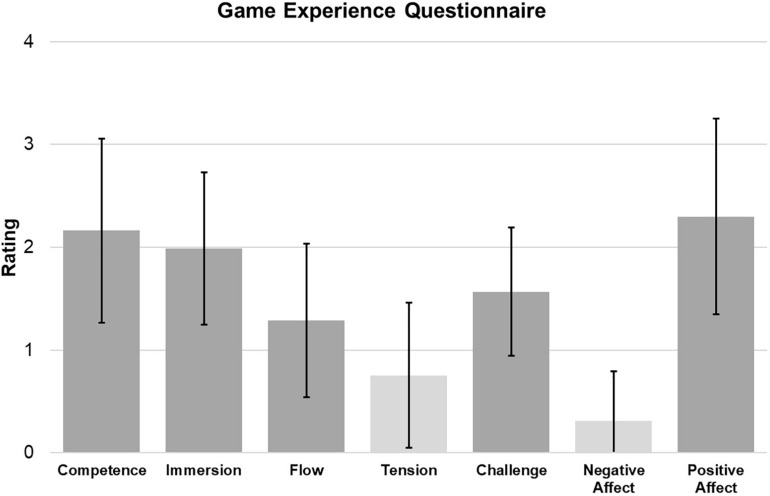
Primary outcome result of game experience. Data shown in the figure are means with standard deviations in each emotional category of the GEQ (n = 17). The two light-gray categories (tension, negative affect) have to be evaluated reversely which means a lower score is favorable. The GEQ ranges from 0 = “not at all” to 4 = “extremly”.